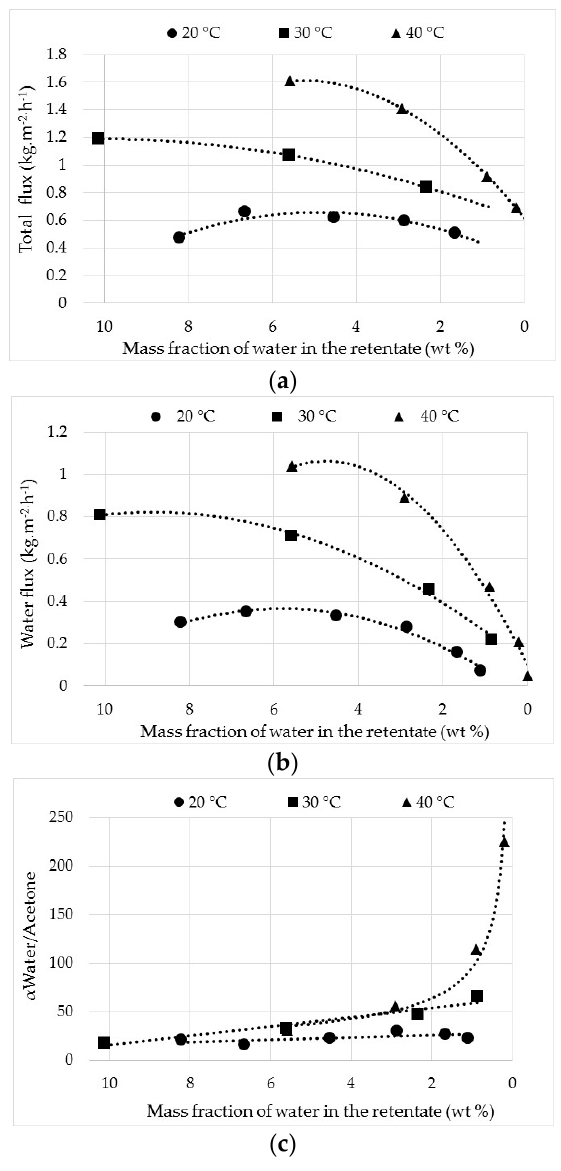
Figure 3. Evolution of total ( a ), water flow ( b ), and separation factor ( c ) from a binary acetone-water mixture (90/10 wt %) through the HybSi ® membrane depending on the water content in the retentate at 20, 30 and 40 °C.